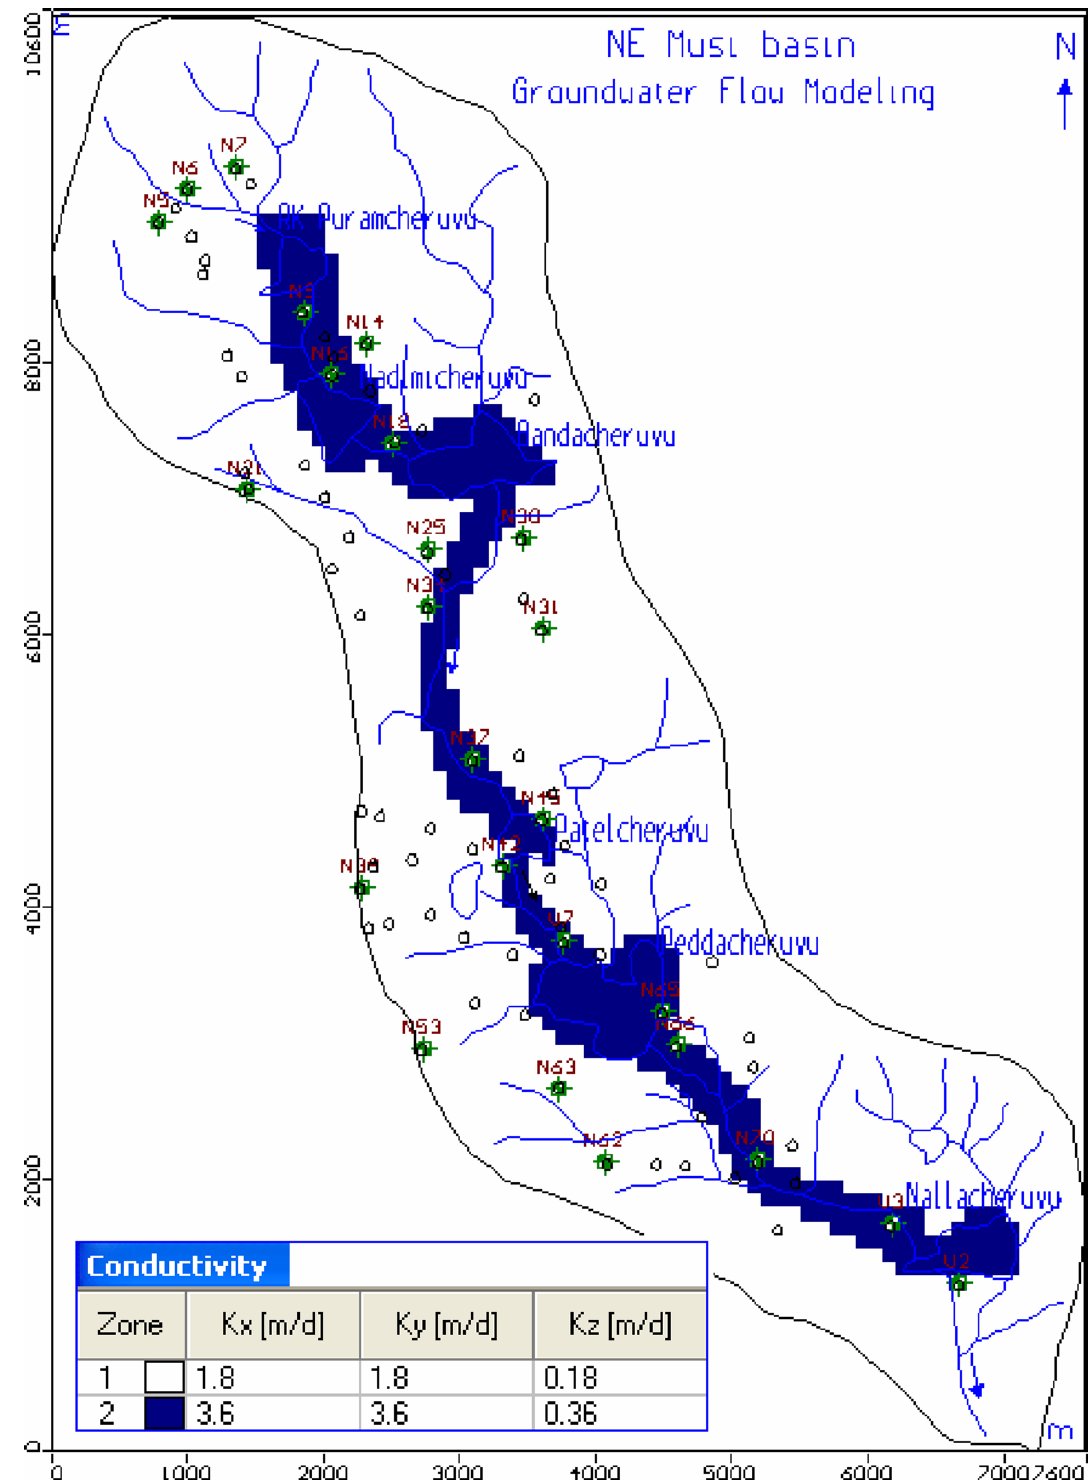
Fig. 5 Permeability distribution (m/day) in NE Musi